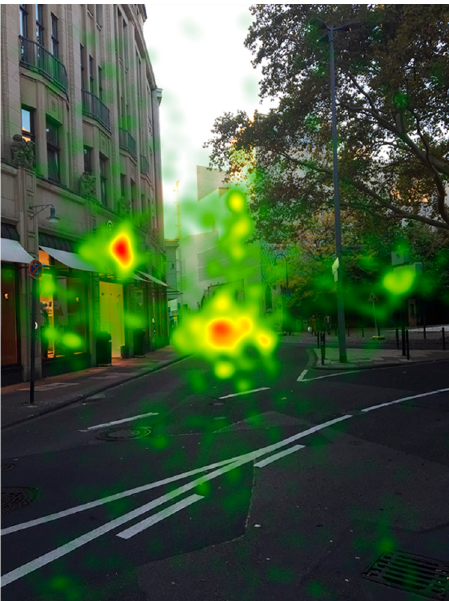
Figure 4. Visualisation of results in the form of a heat map for all subjects for image 1.